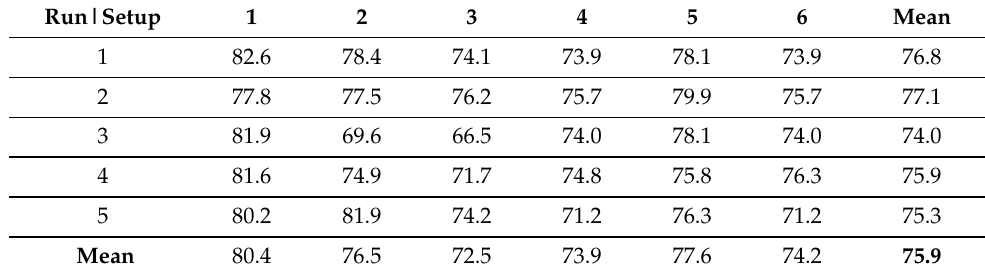
Table 12. Weighted F1-score results on short sentences for six different dataset setup and five runs.